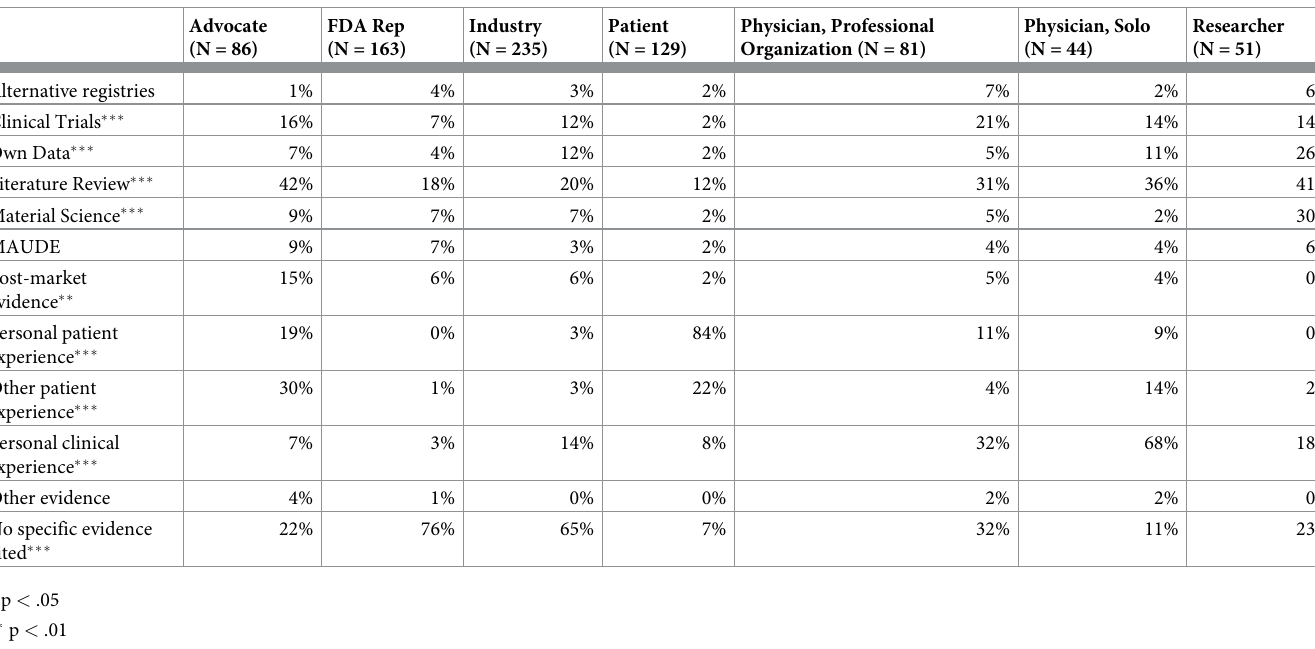
Table 4. Types of evidence by speaker type (N = 789) 1